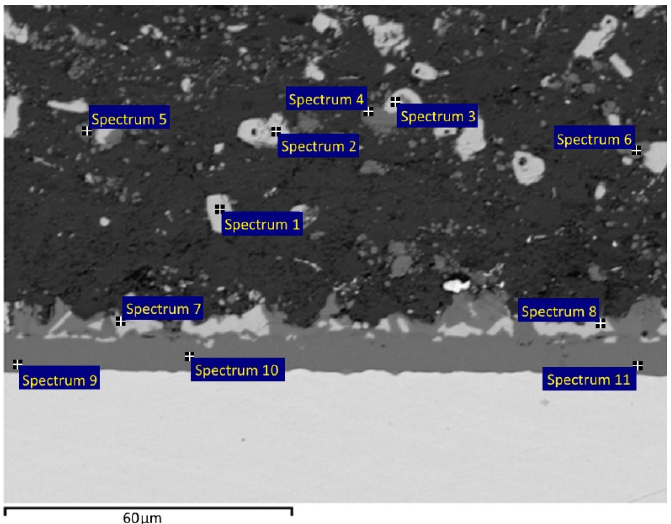
Figure 12. SEM image of the AISI 304/AA 6082 joint brazed according to the 540 °C/30 min mode with the EDX measurement points. Table 6. Results of EDX analysis of the AISI 304/AA 6082 brazed joint. Chemical Composition Measurement Point